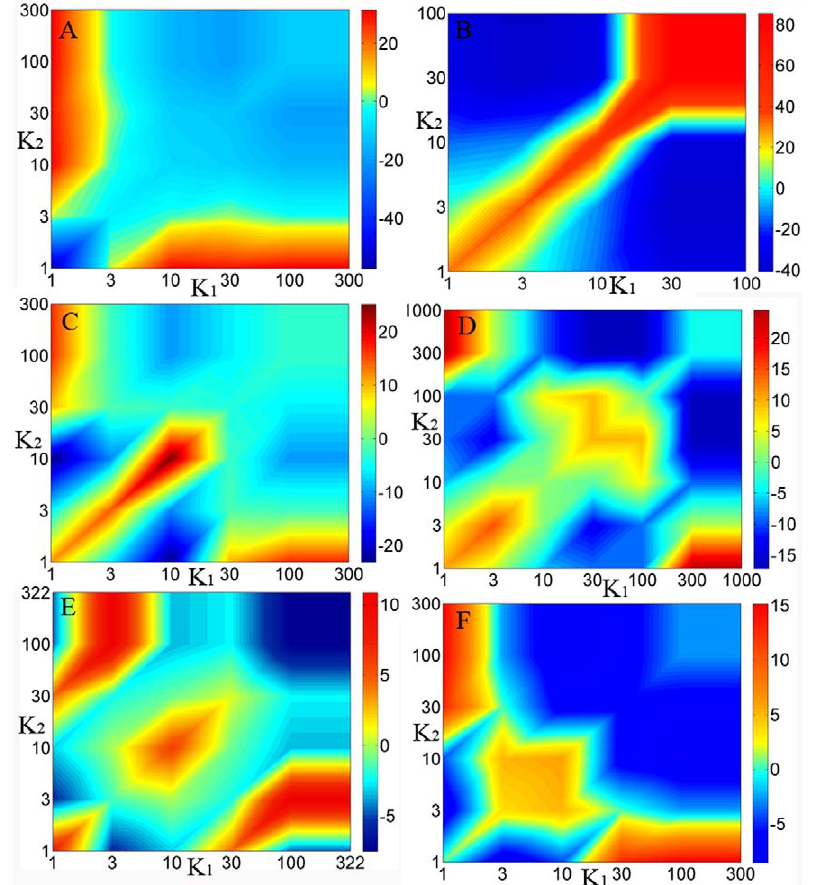
Figure 2. Correlation profiles of complex networks. A. The plot of Z-score of Internet at AS level which is known to be disassortative, where the red color reflects the affinity of nodes and blue color reflects the repulsion between nodes. B. The profile of a social network constructed by collaborations between authors who co-authored a paper, which is known to be assortative. C. The correlation profile of yeast PIN constructed by HC dataset. D. The correlation profile of yeast GIN. E. The profile of yeast metabolic network abstracted from KEGG. F. The correlation profile of HC dataset after removing interactions between proteins within the same complex. Note that through C to F , at least 99% nodes of biological networks are localized in the lower left corner where the diagonal is colored red.